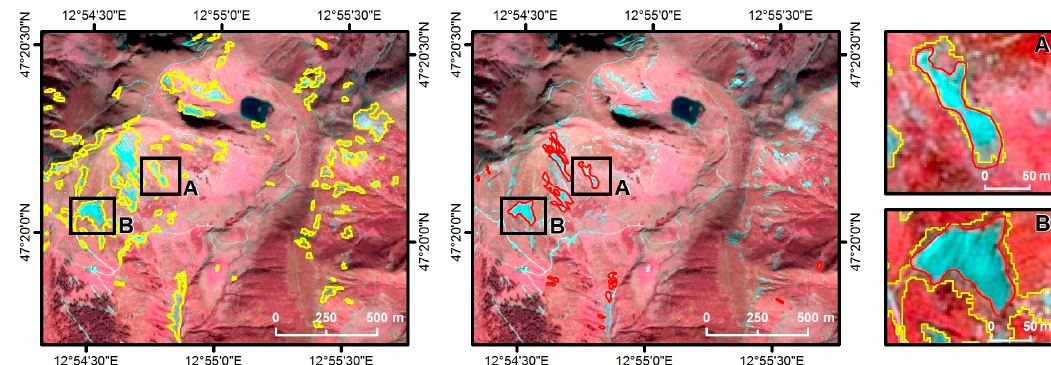
Figure 2. Semi-automatically mapped landslides using the object-based image analysis (OBIA) approach (in yellow; left ) and manually mapped landslides (in red; right ) for study area I based on the Landsat 7 image.